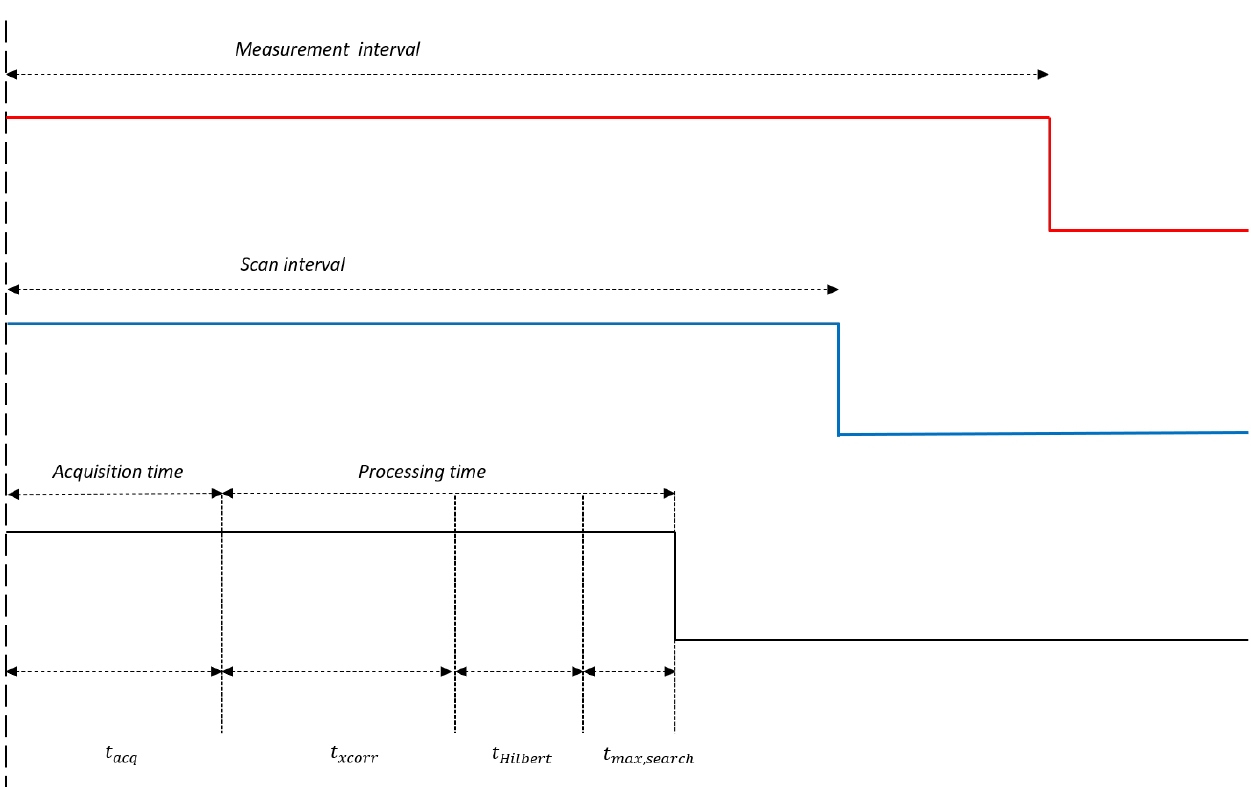
Figure 10. Timing diagram profiling the main activities required by the ToF measurement.